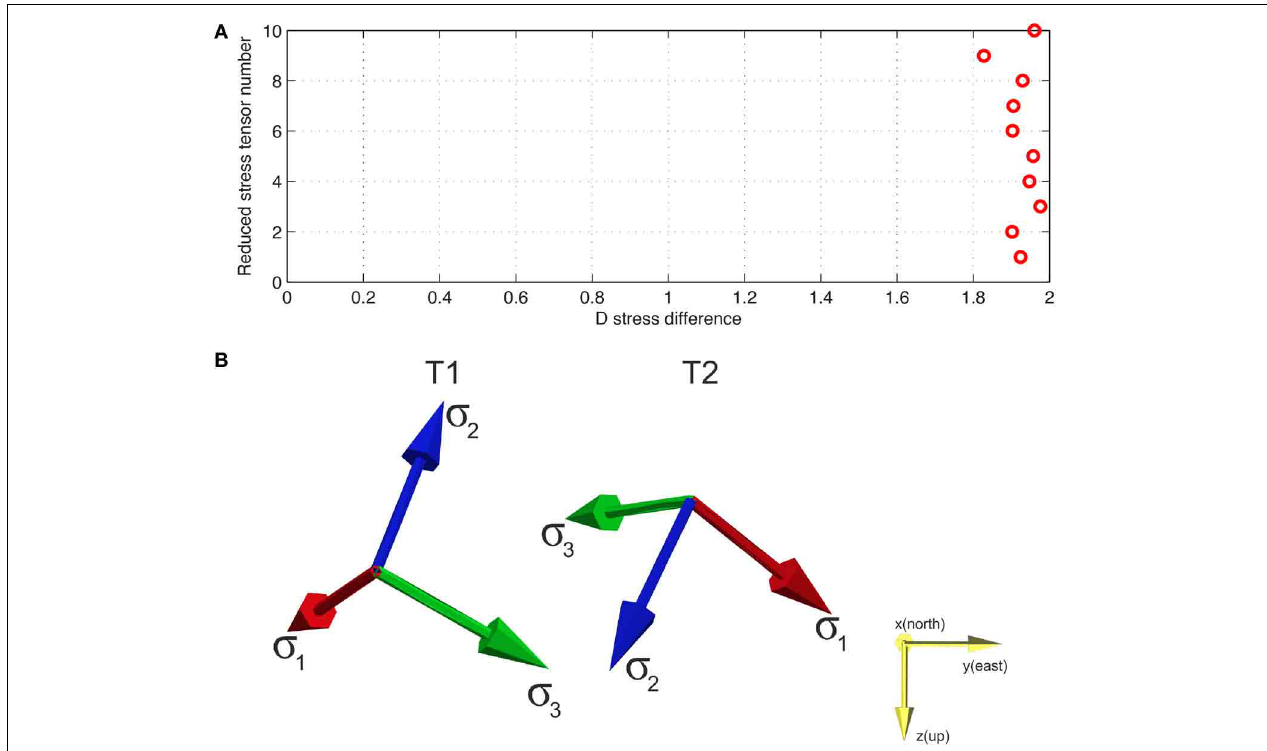
FIGURE 12 | Two opposite reduced stress tensors. (A) Plot of the parameter D (in x-axis) representing a distance between the pair of the 10 best stress tensors solutions of T1 and the best 10 stress tensors of T2 (y-axis, in ascending order where the first one being the best